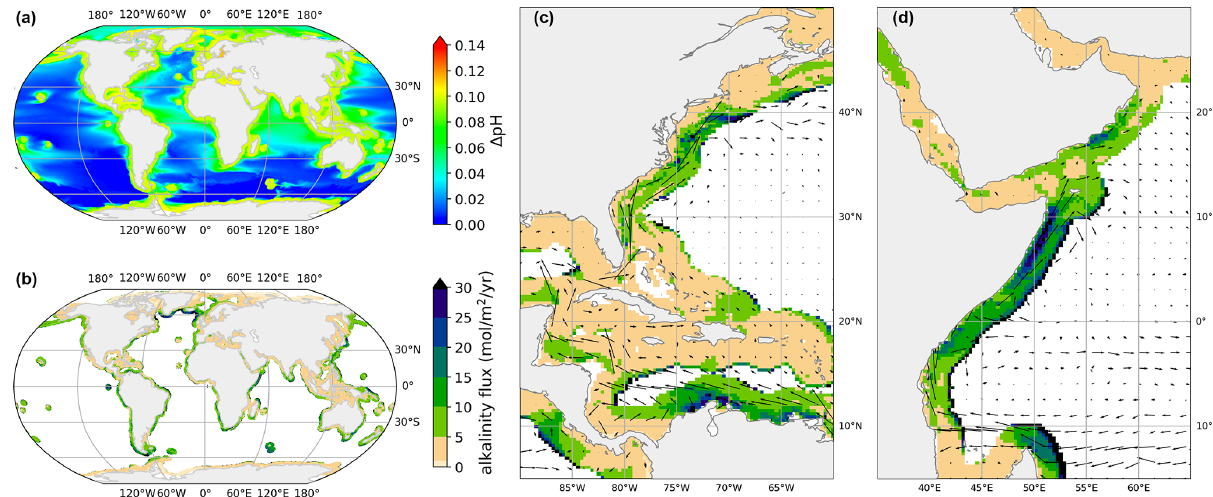
Figure 1. Shown is a coastal injection in a strip 296km wide, subject to (cid:49) pH tgt = 0 . 1. All time-averages ran over 5–20 years. (a) Averaged pH change compared to a reference simulation with no added alkalinity. (b) Average alkalinity flux at each grid point from the coast. (c, d) Injection flux for two example regions. Annually averaged surface currents are overlaid as a vector field.